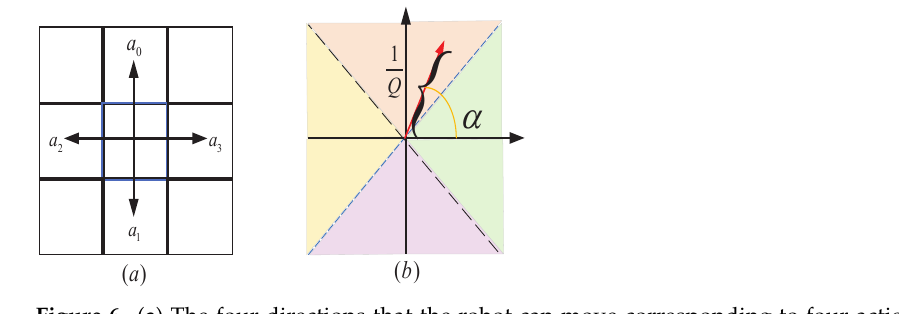
Figure 6. ( a ) The four directions that the robot can move corresponding to four actions. ( b ) The way to convert angles to actions, which 360 degrees are divided into four sections, that is, (cid:2)